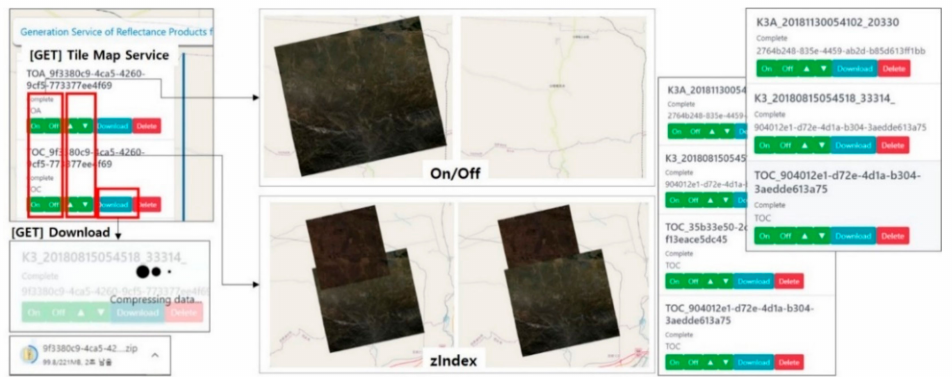
Figure 8. Product view, downloading, and deletion processes in the SaaS.